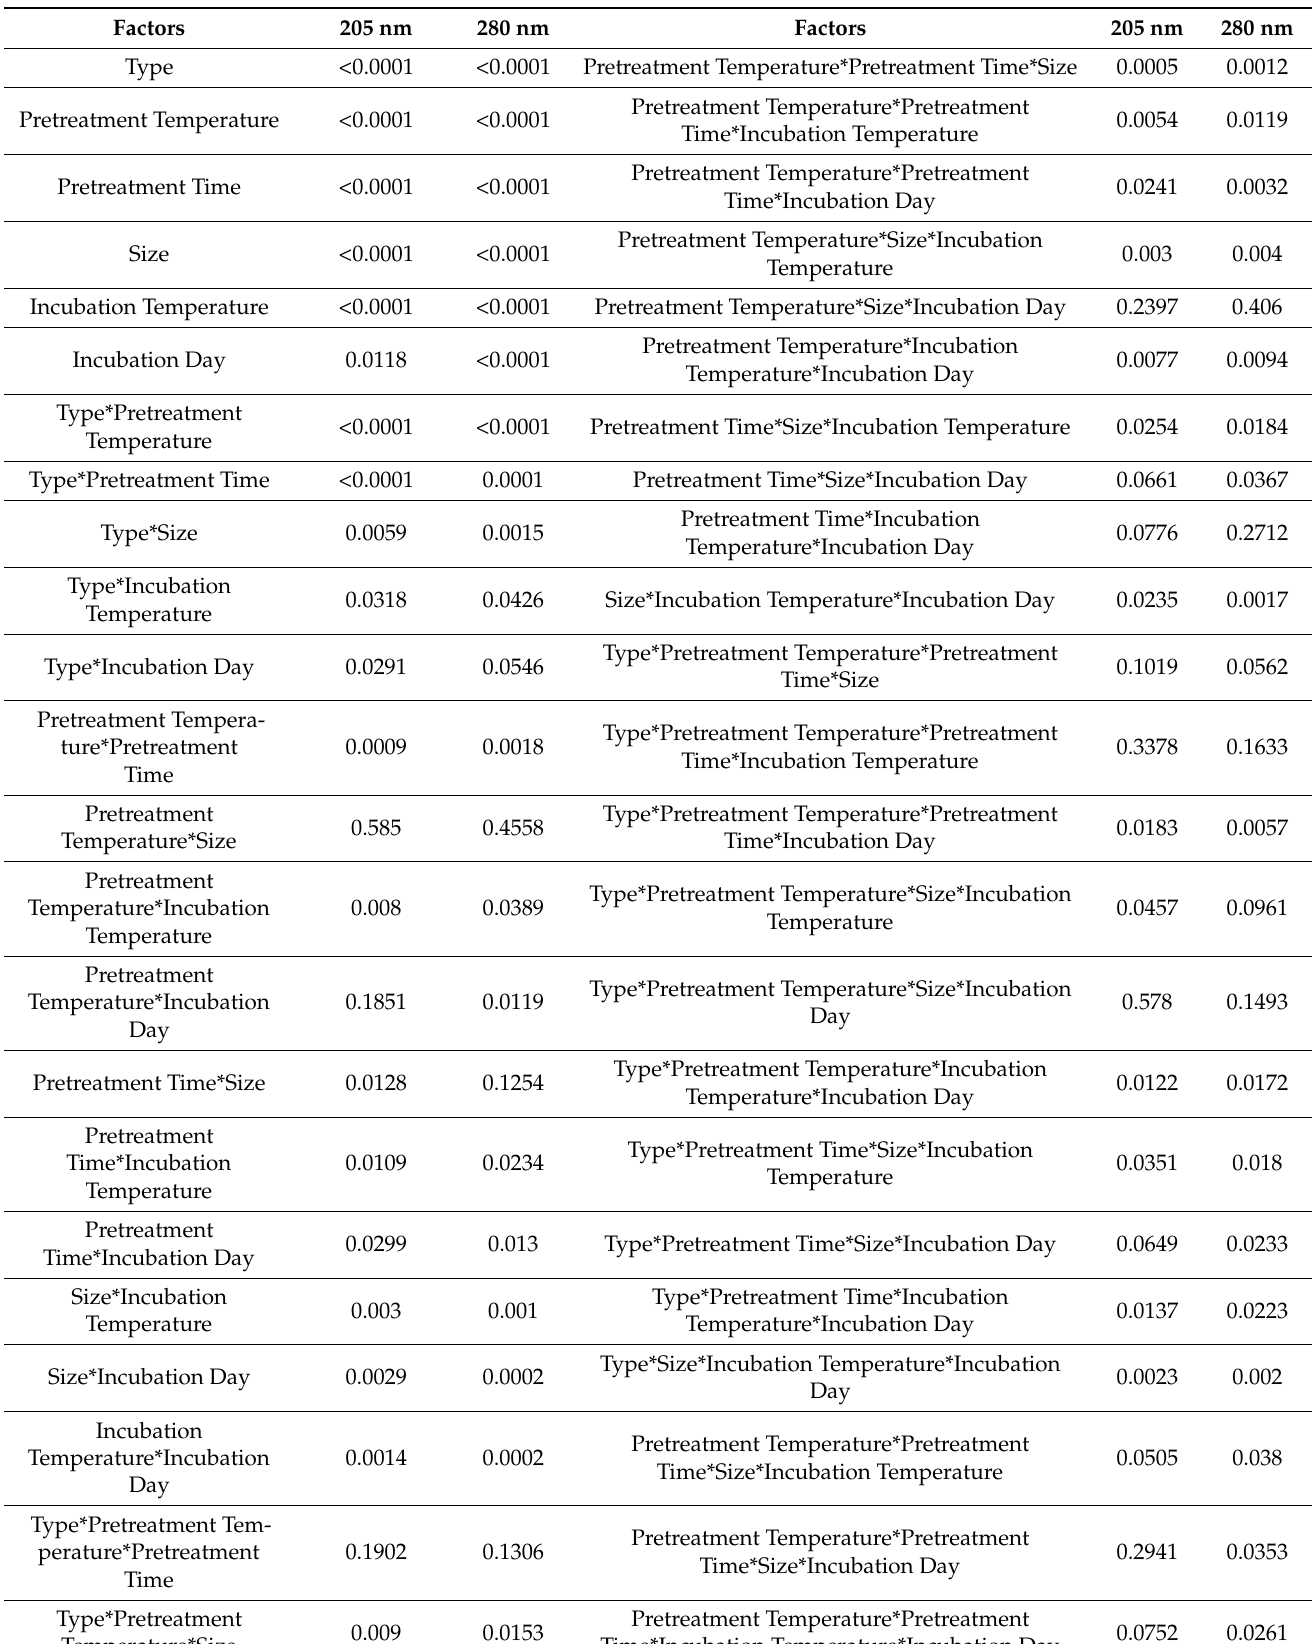
Table 11. p -value summary for soluble lignin yield